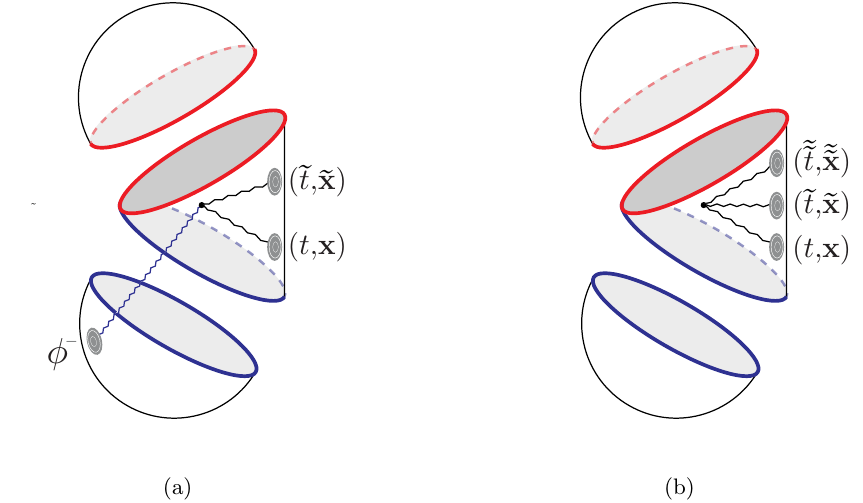
Figure 5 . Examples of diagrams contributing to the 2- and 3-pt functions corrections. The diagram in (cid:12)gure(b) manifests the source independence of the (cid:12)rst order correction to the 3-pt function.